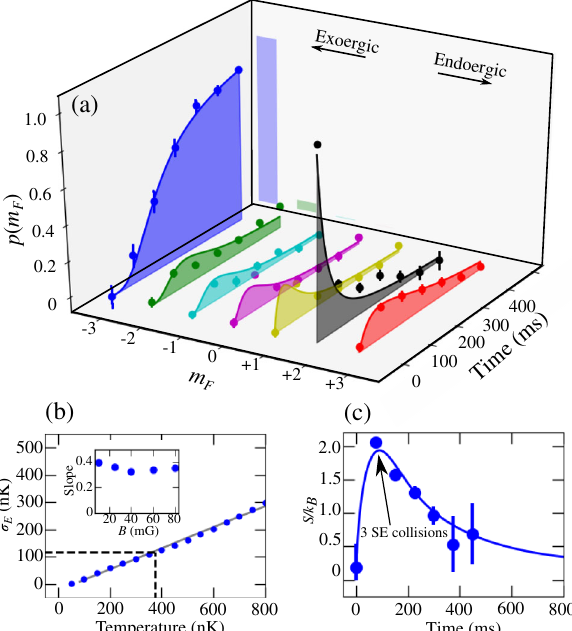
FIG. 3. Information gain from the spin distribution of quantum probes. (a) Quasispin-state dynamics of Cs atoms immersed in a Rb bath at T ¼ 366 þ 60 − 40 nK at a fixed magnetic field B ¼ 25 mG [expected endoergic fraction p ð B; T Þ ¼ 0 . 54 ]. Experimental time trace (dots) and theoretical predictions of our rate model (solid line, for details see Appendix D) are shown. Each experimental point is an average over approximately 200 measurements, and the error bars indicate the statistical uncertainties in the atom number determination. The histogram projected in the back plane shows the steady-state spin distribution. (b) Theoretically calcu- lated probe-energy fluctuations σ 2 of the steady state for B ¼ E 25 mG calculated from modeled quantum-state distributions as P h E 2 i ¼ E 2 P , with E and P being the energy and m F m F m F m F m F . The P are the population probability of quantum state m F m F steady-state solutions of our rate model. Dashed lines direct to T ¼ 366 nK. Inset: Slope of the linear trend between σ and T E for different values of the magnetic field. (c) Time evolution of the probe entropy calculated from the spin populations of (a). The time of maximal entropy corresponds to an average of three SE collisions (0.5 endoergic and 2.5